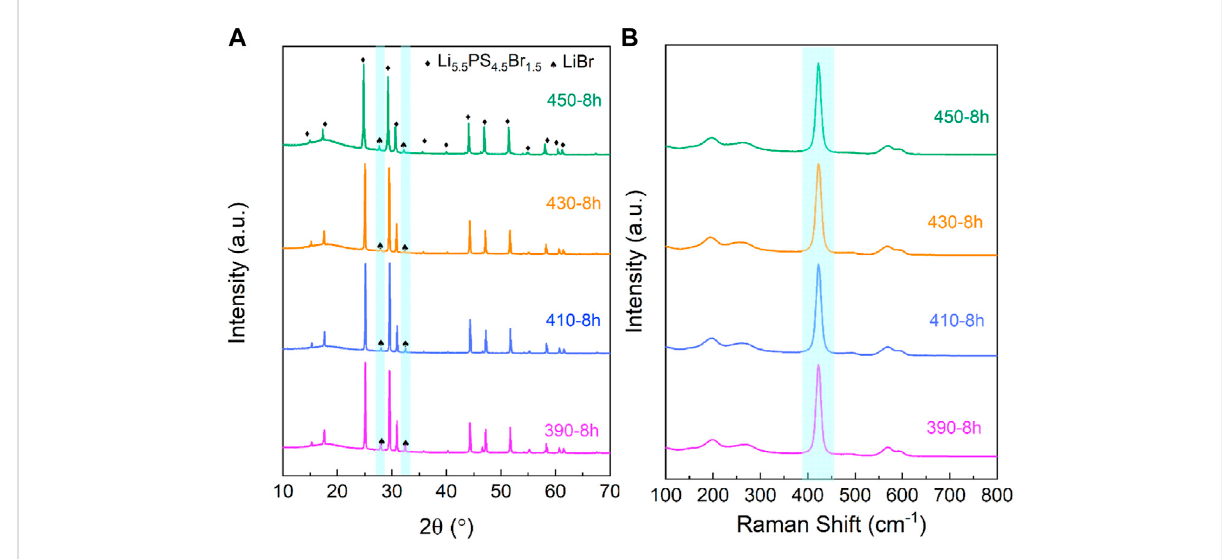
FIGURE 1 XRD patterns (A) and Raman spectra (B) of the LPSB samples synthesized by solid-state reaction at different temperatures for 8